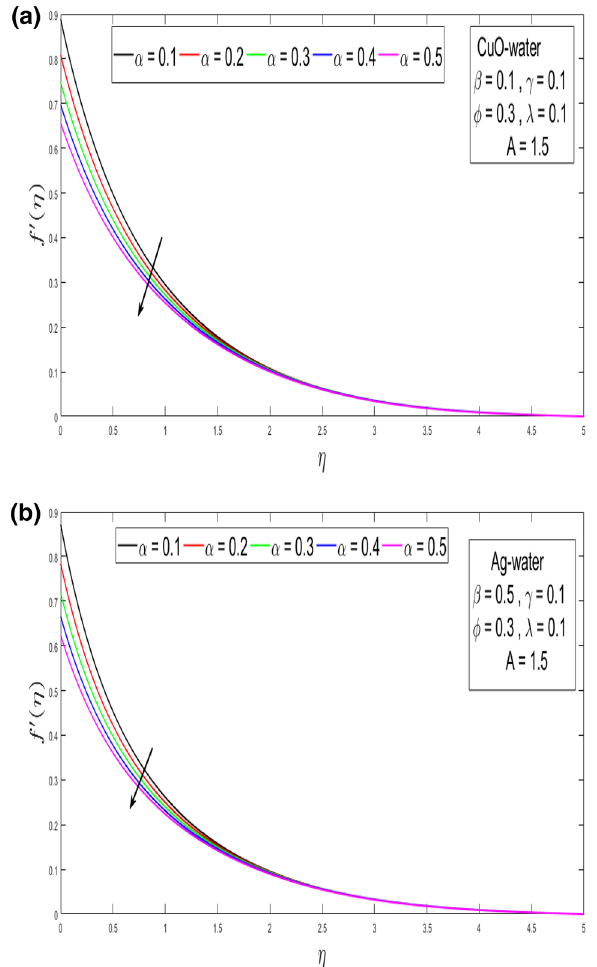
Figure 2. ( a ) Influence of velocity slip α parameter above f ′ (η) for CuO nanoparticle. ( b ) Influence of velocity slip α parameter over f ′ (η) for Ag